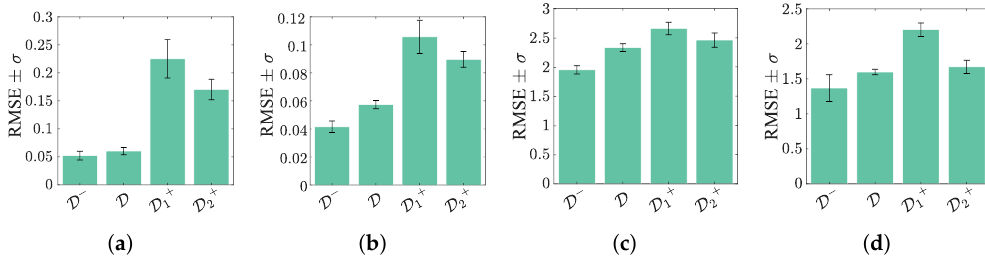
Figure 17. NN-based surrogate accuracy for the design spaces D , D − , D + STL problem with different approaches: ( a ) infinite plate; ( b ) correction factor; ( c ) modal summation; ( d ) modal summation with 1/3 octave band